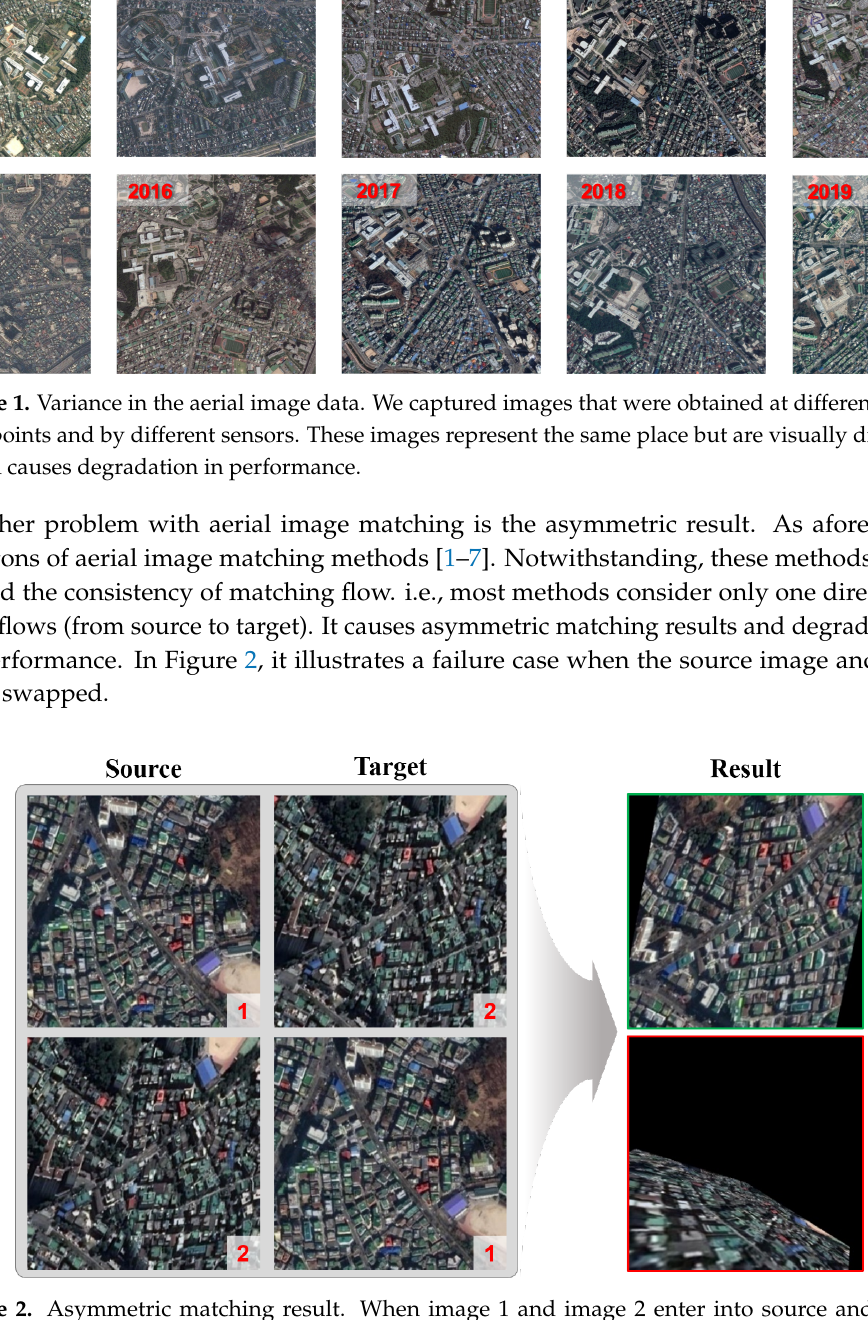
Figure 2. Asymmetric matching result. When image 1 and image 2 enter into source and target respectively, the matching process is successful. In the opposite case, however, it completely